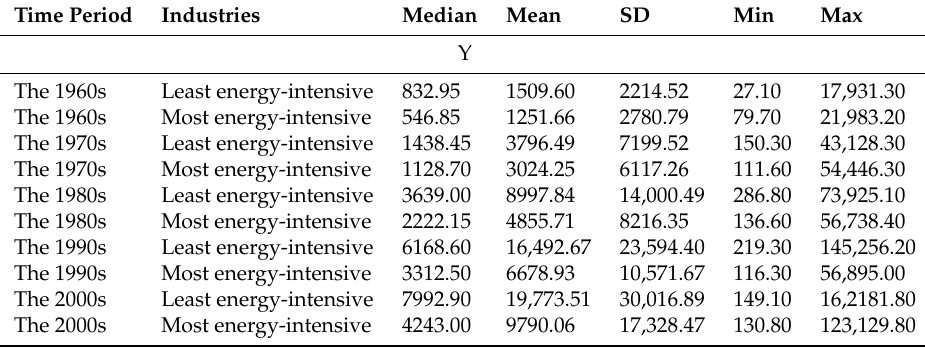
Table A1. Descriptive statistics by decade and by the intensity of energy